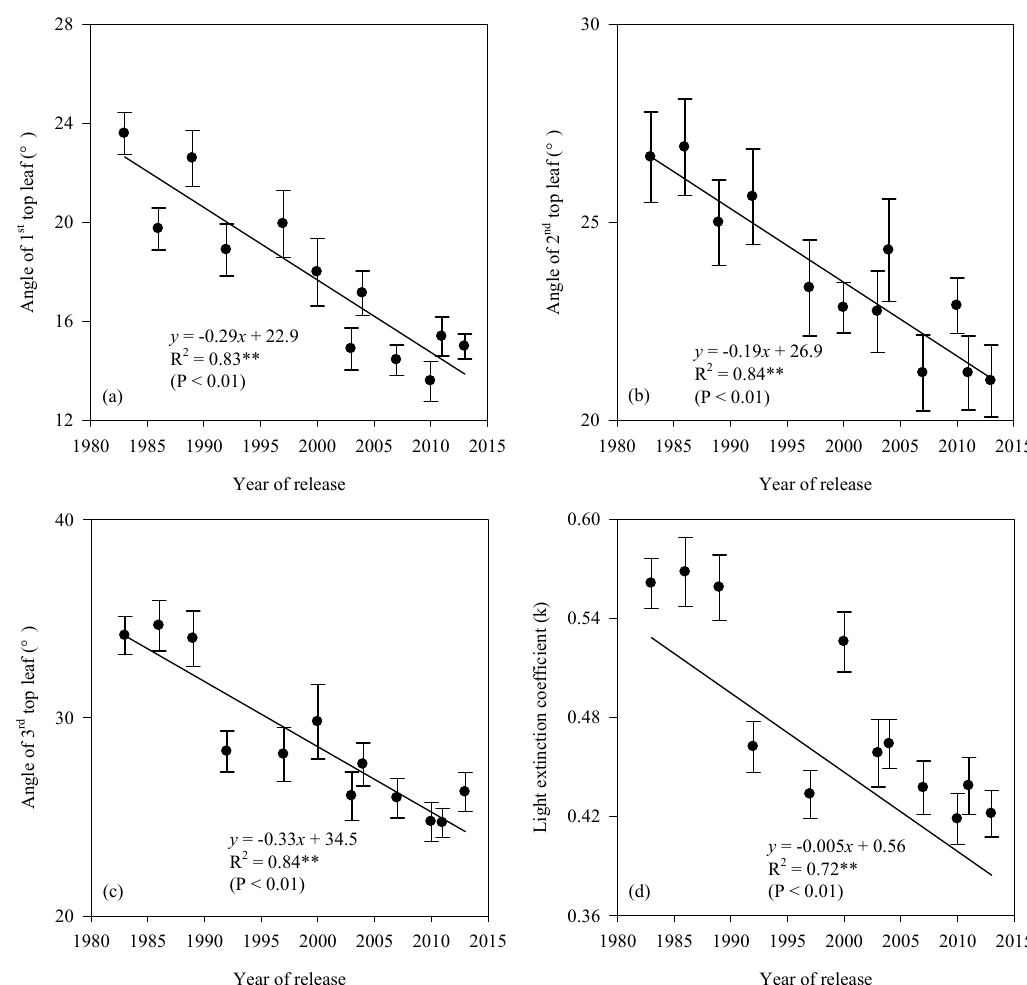
Figure 5. Relationships between year of release and angle of top three leaves ( a – c ) and light extinction coefficient ( d ) at 30 DAH of rice cultivars. DAH, days after heading. Data were fitted by linear regression ( y = a x + b). In the linear regression, x was reassigned as years after 1983; for example, x was valued as 1 in 1983 and so on. **, significant at the 0.01 probability level according to the LSD test. Vertical bars represent ± standard error of the mean ( n = 6).